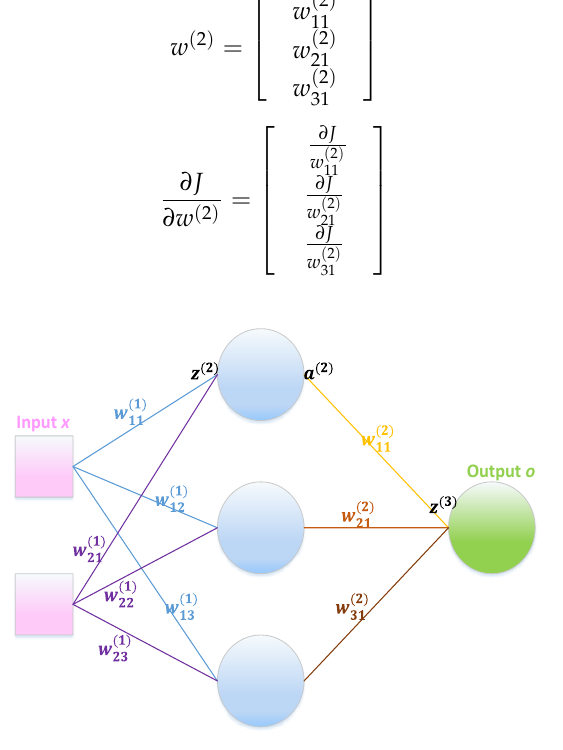
Figure 7. Two-layer neural network.